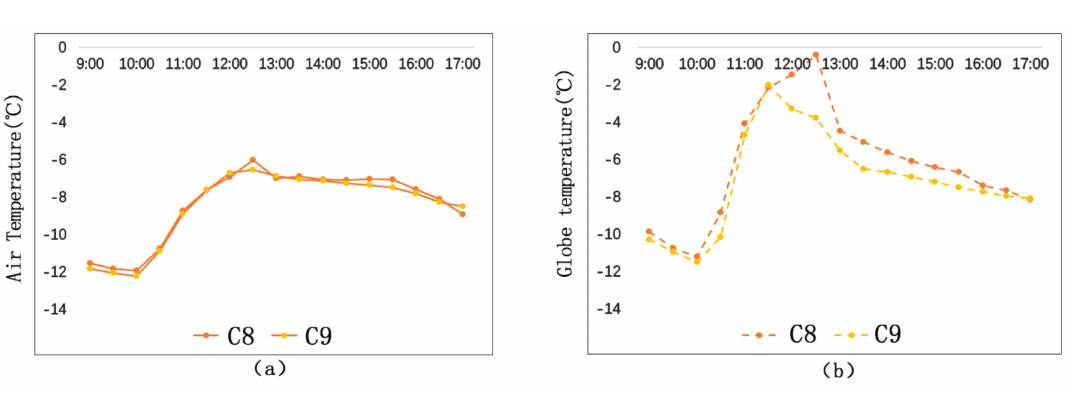
Figure 12. Air temperature comparison and globe temperature comparison on street-entry type streets: ( a ) Ta; ( b )